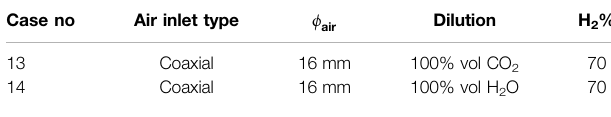
TABLE 3 | Summary of the operating conditions for the diluted, coaxial injector